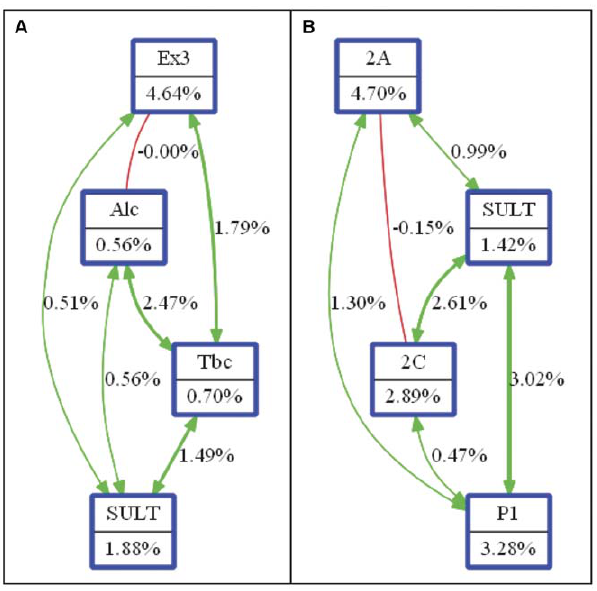
Figure 2. Interaction entropy graphs. The interaction model describes the percentage of the entropy (information gain) removed by each variable (main effect: represented by nodes) and by each pairwise combination of attributes (interaction effect: represented by connections). Attributes are selected on the basis of MDR results obtained in case of ( A ) Smokers and ( B ) Non smokers. Labels: Ex3: EPHX1 Tyr113His, Alc: alcohol consumption, Tbc: Tobacco chewing, SULT: SULT1A1 Arg213His, 2A: CYP1A1*2A, 2C: CYP1A1*2C , P1: GSTP1 Ile105Val.